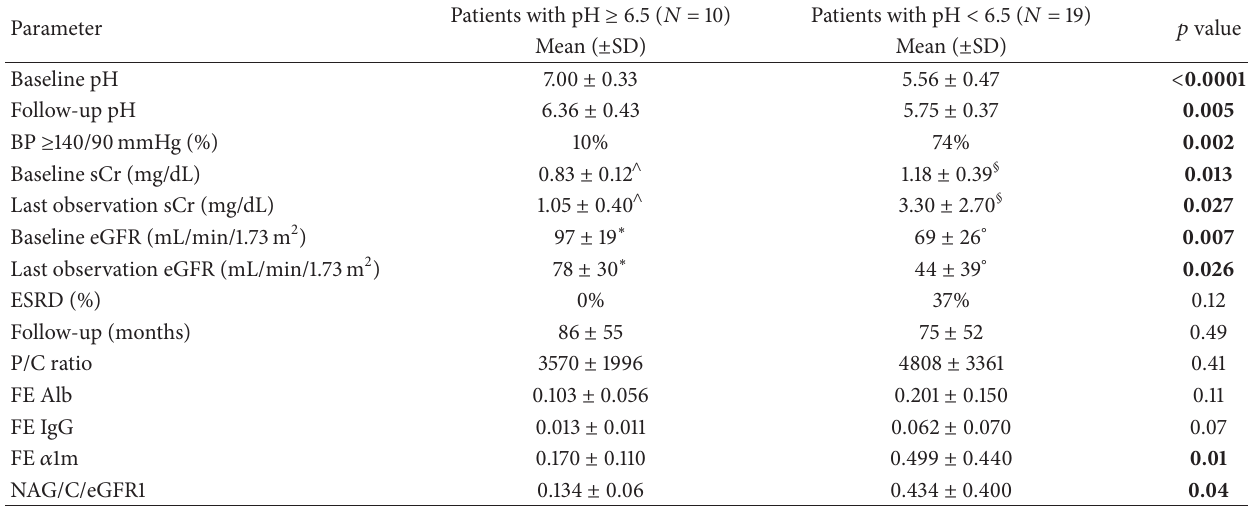
Table 3: Baseline and last observation clinical, functional, and proteinuric parameters in 29 IMN with NS patients treated with supportive therapy with UpH ≥ 6.5 ( 𝑁 10) or UpH < 6.5 ( 𝑁